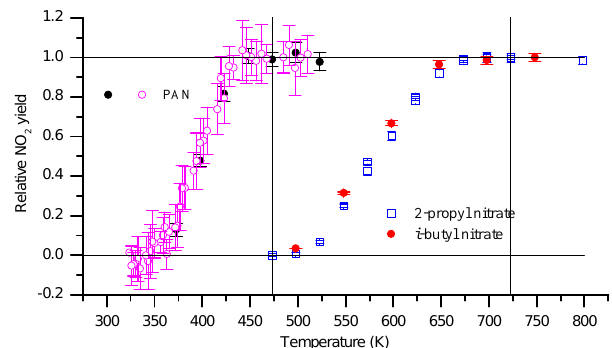
Figure 3. Efficiency of thermal dissociation of PAN and the ANs 2-propyl nitrate and i -butyl nitrate. PAN ( ≈ 500pptv) was formed by the photolysis of acetone/NO/air sample (see text for details). The purple and black data points were measured before and after a campaign ( ≈ 2 months separation in time). The ANs were available as diluted samples (several parts per million by volume, ppmv) in air which were diluted to ≈ 10ppbv for these tests. The vertical lines indicate the nominal oven temperatures finally